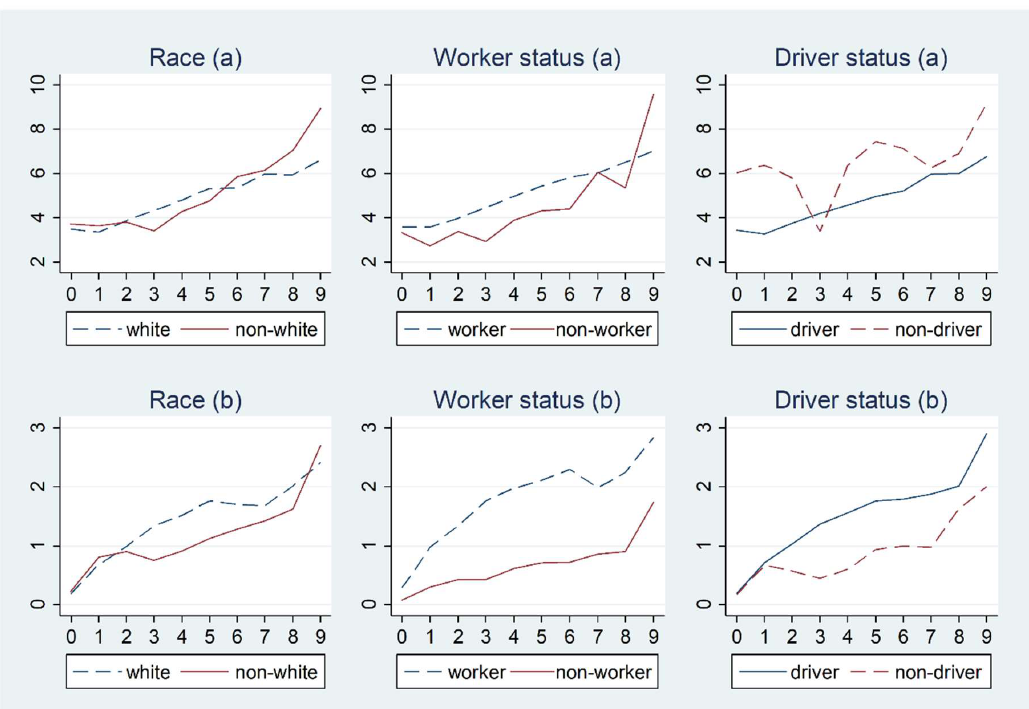
Figure 4. Relationship between ridesharing and public transit use varying by race, worker, and driver status for those who use ridesharing in the past 30 days: (a) 1–99 times; (b) 0–99 times.